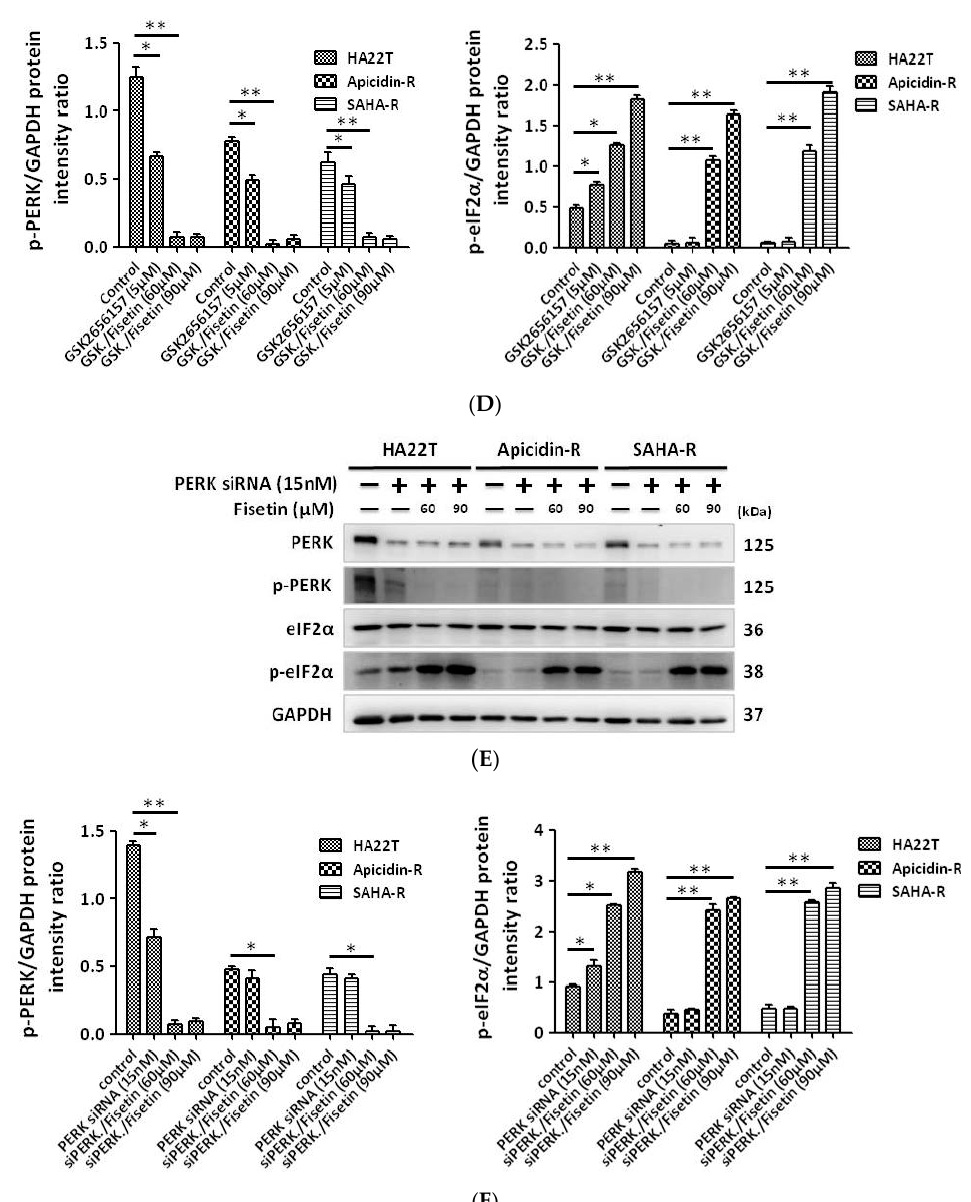
Figure 3. The ER stress molecular pathways cannot regulate eIF2 α activation in HCC cells after treatment with fisetin. Cells were treated with thapsigargin (TG) or fisetin to determine whether the activation of phosphorylated eukaryotic translation initiation factor 2 subunit α (p-eIF2 α ) was regulated by PERK in HCC cells, and this activation was confirmed by GSK2656157 or small interfering RNA (siRNA). ( A , B ) The level of p-eIF2 α in liver cancer cells was increased in a dose-dependent manner after treatment with fisetin without PERK activation. Western blotting data were quantified by densitometry and the ImageJ software, and normalized to glyceraldehyde 3-phosphate dehydrogenase (GAPDH). * p < 0.05, ** p < 0.01, *** p < 0.001 compared with the control group. ( C – F ) p-PERK knockdown by GSK2656157 or siRNA cannot reverse the effects of dephosphorylation on eIF2 α. All protein samples were analyzed by western blotting. The protein expression was normalized to GAPDH. * p < 0.05, ** p < 0.01, *** p < 0.001 compared with the control group.